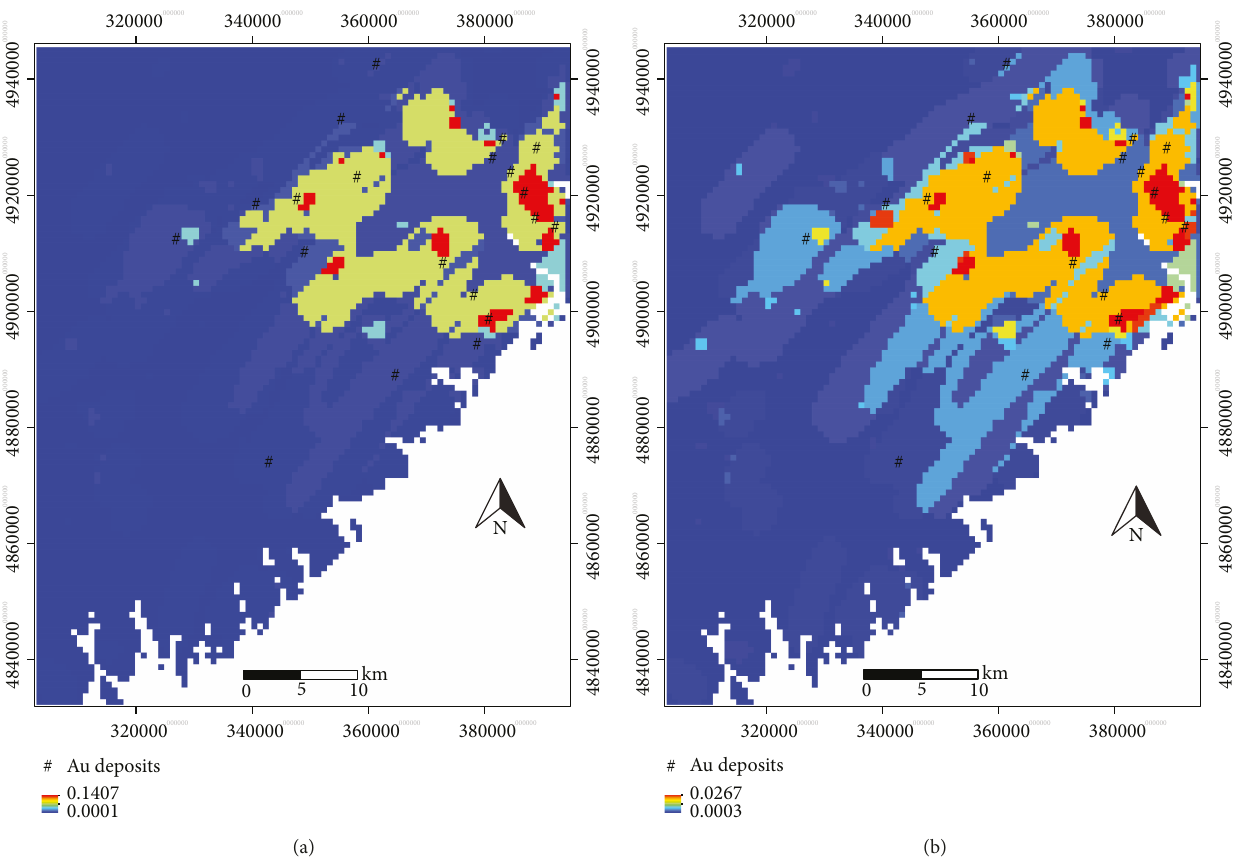
Figure 3: Posterior probability maps obtained by (a) weights of evidence and (b) logistic regression in experiment